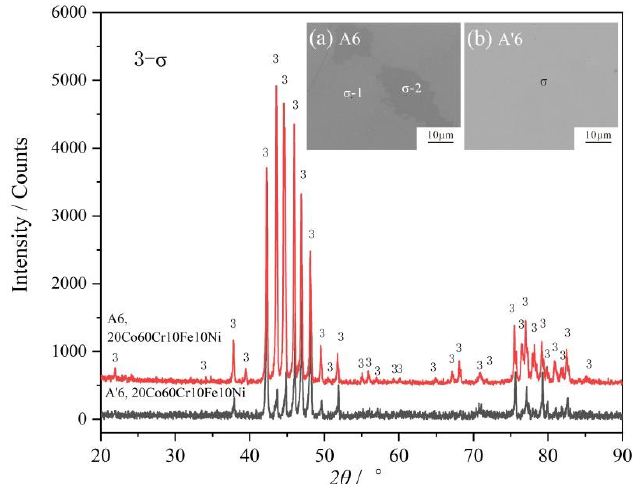
Figure 8. XRD patterns of the alloys A6 before and after annealing 1000 °C for 30 days. The inset figures are the related BSE micrographs.